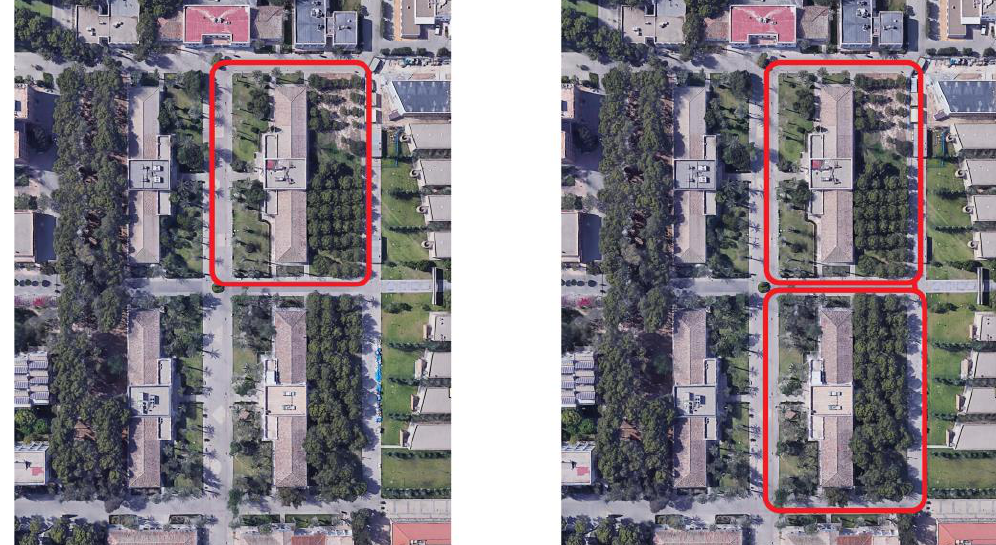
Figure 12. ( left ) Path R 1 around the building located in the upper right quadrant. This path runs entirely through the map shown in Figure 11. ( right ) path R 2 around the two buildings on the right side of the image. This path leaves the map in the area of the building in the lower right quadrant of the image.